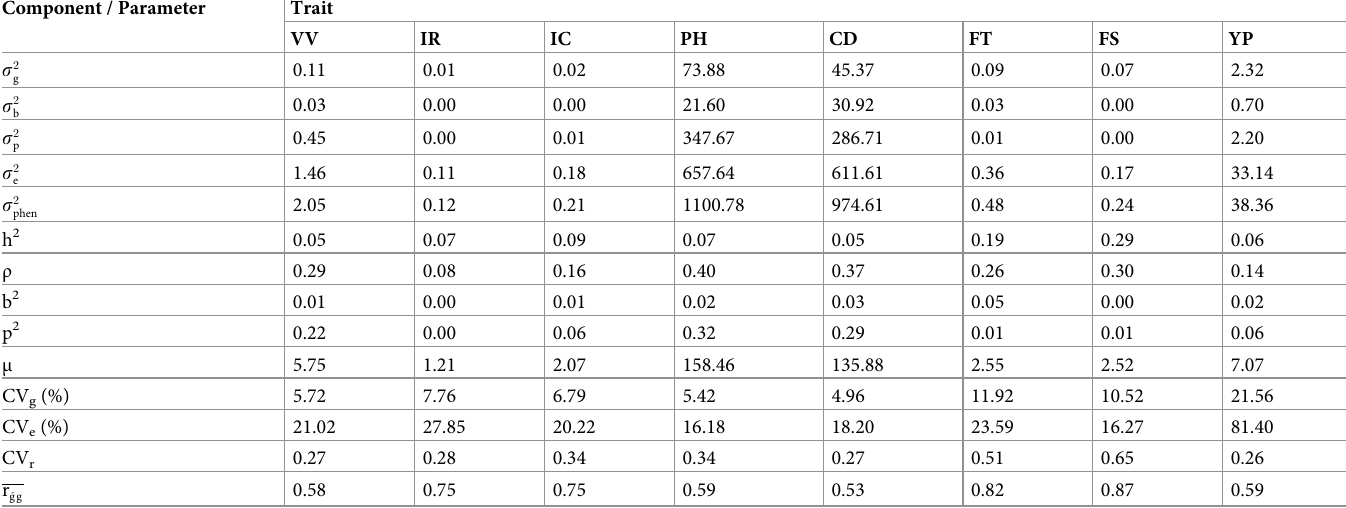
Table 5. Estimates of variance components and genetic and environmental parameters for the following traits: Vegetative vigor (VV), incidence of rust (IR), inci- dence of cercosporiosis (IC), plant height (PH), canopy diameter (CD), fruit ripening time (FT), fruit size (FS), and yield per plant (YP), evaluated in the robusta coffee population. Component / Parameter